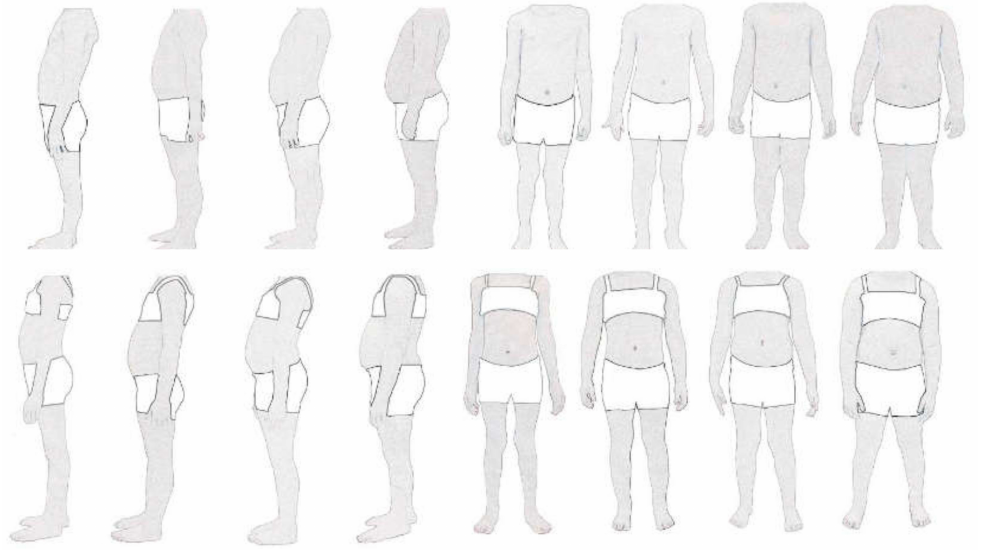
Figure 1. Images corresponding to the male and female sex respectively. Note. From “Development and validation of the preschoolers body scale”